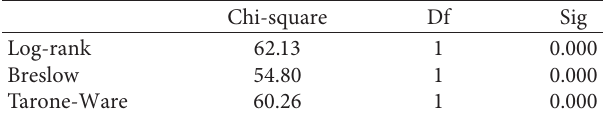
Table 5: Overall test of